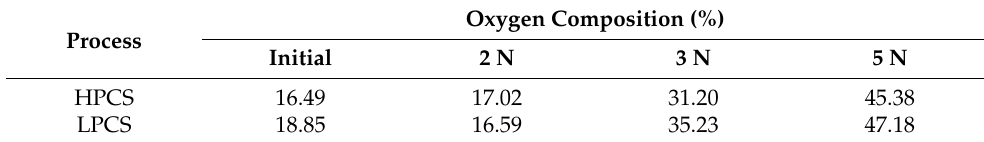
Table 4. EDX result of HPCS and